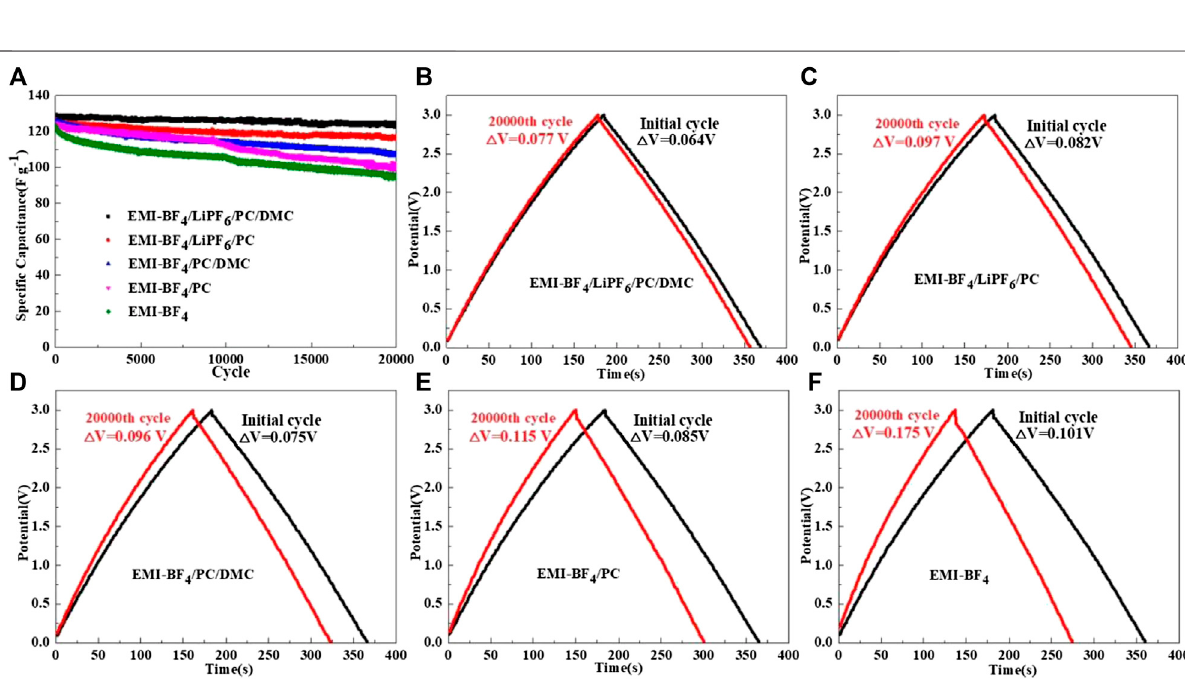
FIGURE 3 | (A) CV curves of the EDLC in EMI-BF4 at the varied potential windows; (B) CV curves of the EDLCs in various electrolytes at a scan rate of 5 mV s − 1 .